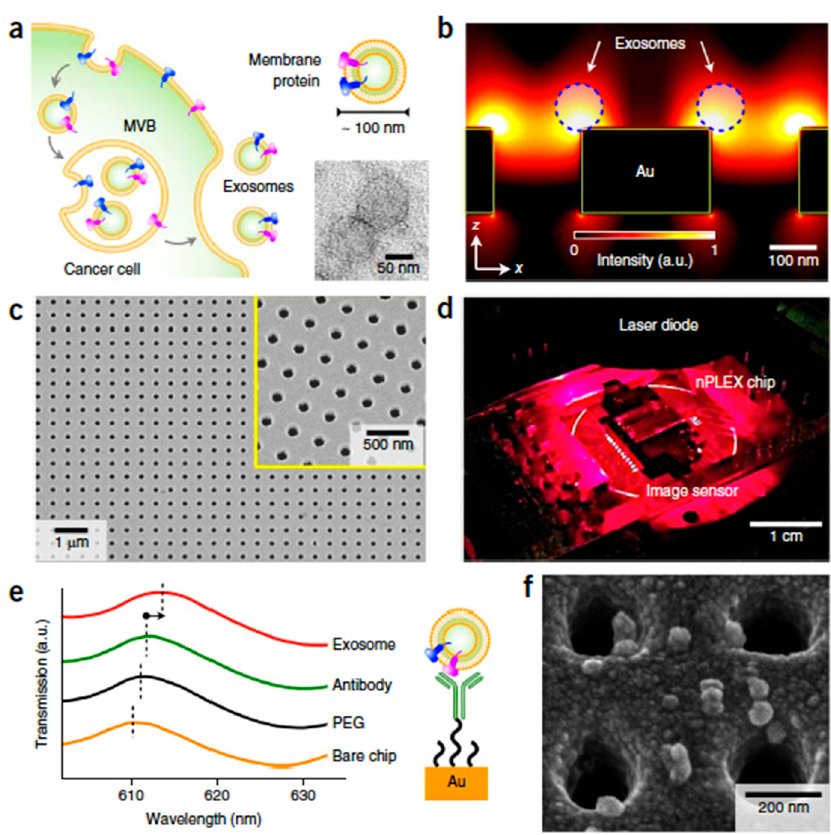
Figure 3. Detection of exosomes using the nano-plasmonic exosome (nPLEX)—sensor developed by Im et al. [110]. ( a ) Exosomes secretion. ( b ) Simulation results of the electromagnetic field justifying the trapping of exosomes on the sensor’s surface. ( c ) SEM image of the nanoholes. ( d ) nPLEX chip and the imaging system. ( e ) Transmission spectra for exosome detection with nPLEX. ( f ) SEM of the nanoholes with trapped exosomes (reproduced with permission from [110], © 2014 Nature publishing group).